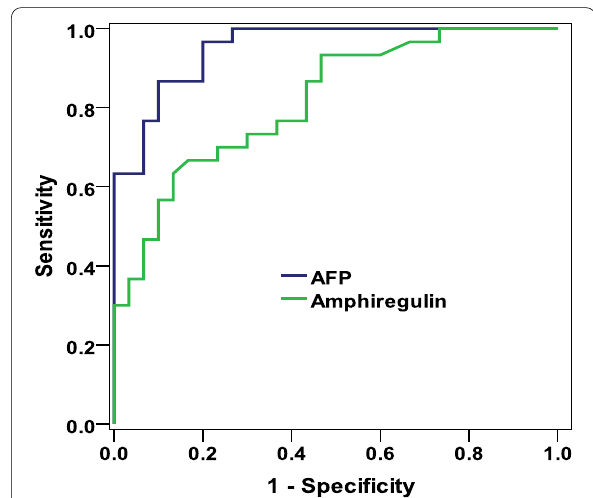
Fig. 1 ROC curve for AFP and amphiregulin in differentiating HCC from cirrhosis